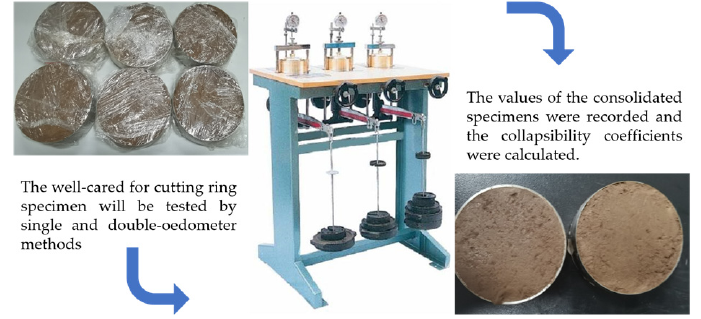
Figure 3. Block diagram of collapsibility